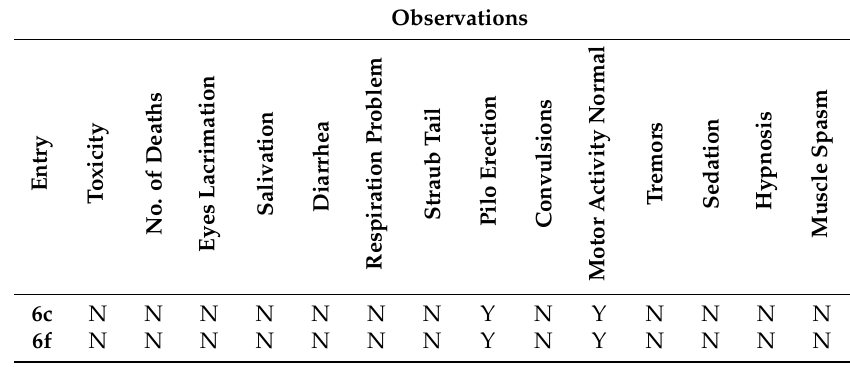
Table 12. In vivo acute oral toxicity study and gross behavioral studies of the synthesized compounds 6c and 6f .